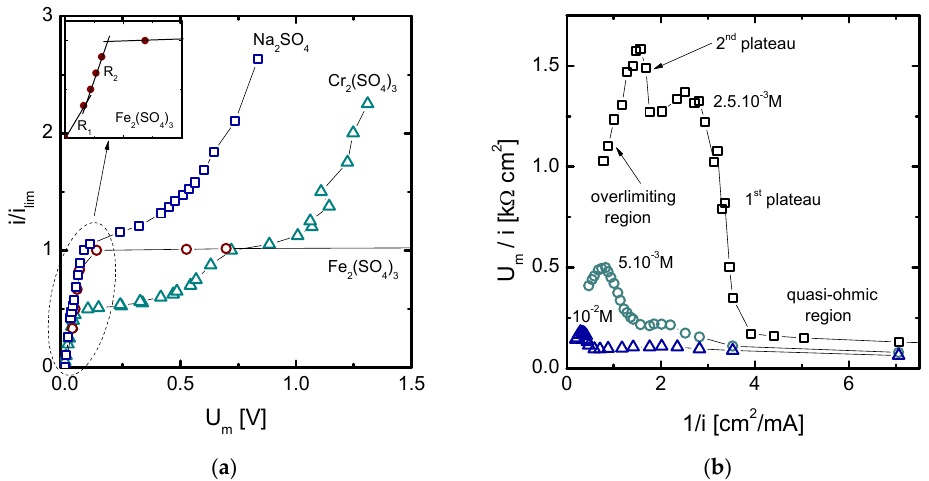
Figure 5. ( a ) Normalized current-voltage curves obtained for different solutions and ( b ) Cowan-Brown plot obtained for Cr 2 (SO 4 ) 3 solutions of different concentrations.